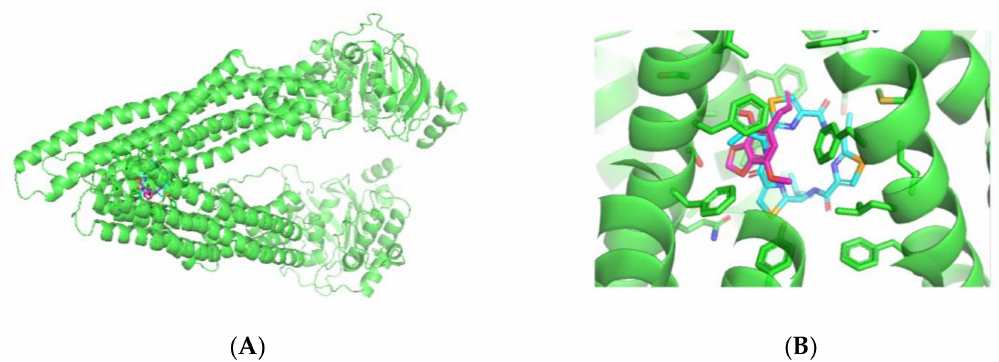
Figure 5. Graphical representation of binding mode of P-glycoprotein, apiole and macrocycle ( A ). Detail of the bindind pocket of ligands to the P-glycoprotein, showing its sites occupied by Apiole and macrocycle ( B ). Ligands are represented by the pink (apiole) and blue (macrocycle) color; P-gp is represented by the green